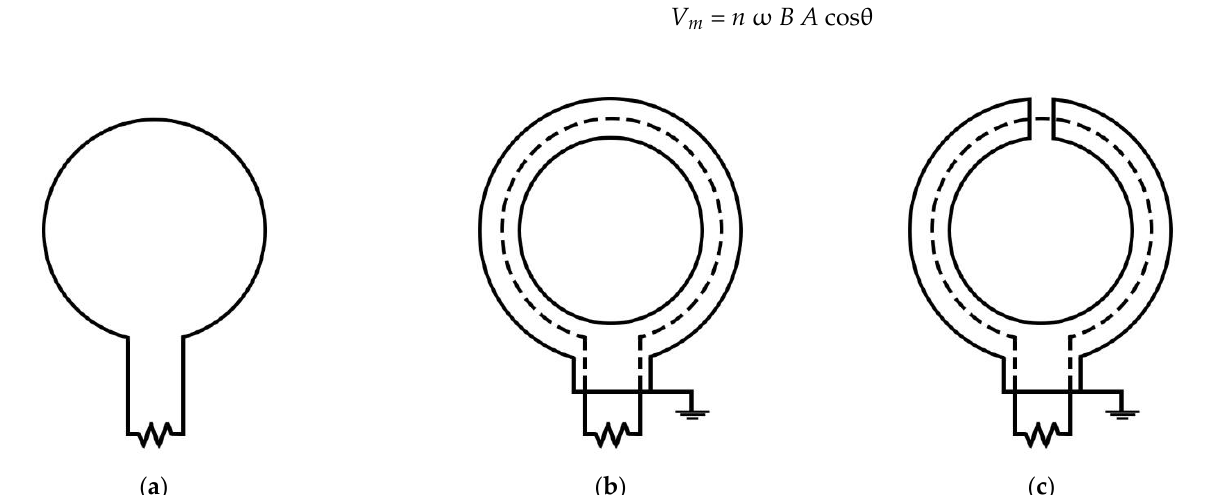
Figure 2. Three different NFP designs: ( a ) basic unshielded loop probe; ( b ) loop probe shielded; ( c ) loop probe with split shield.